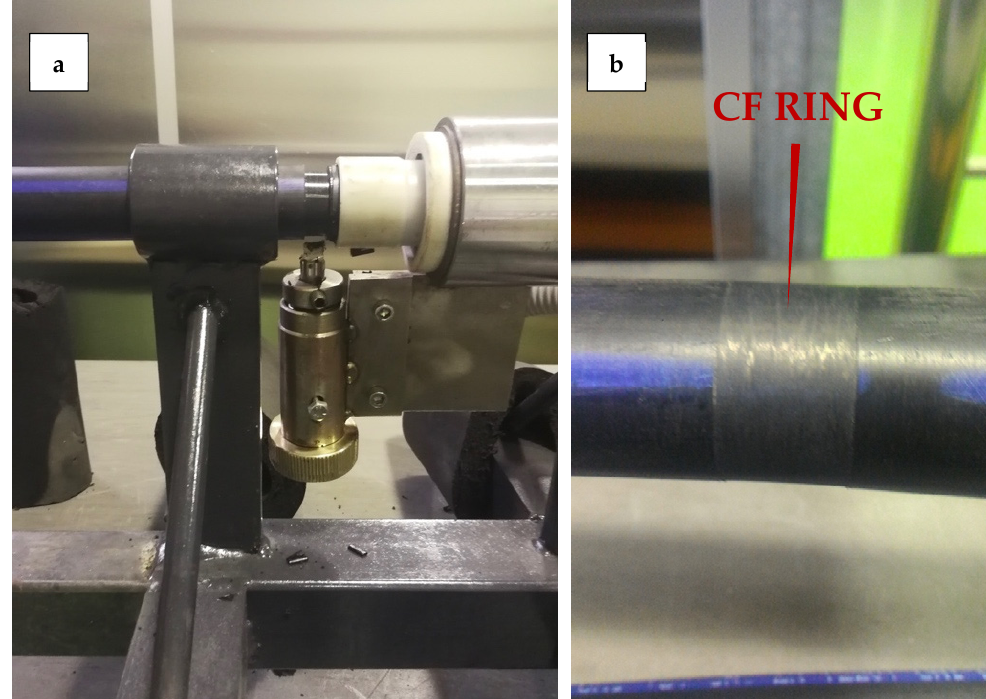
Figure 1. ( a ) Production of the innovative probes with radial carbon fibre (CF) rings and ( b ) finishing of the radial CF rings.